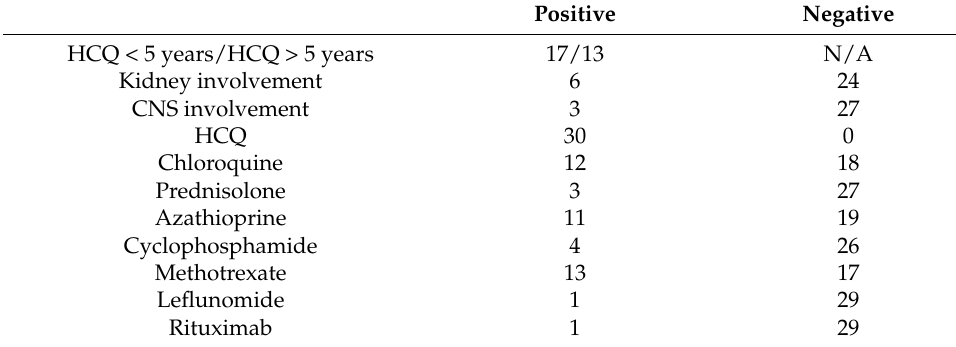
Table 2. Rheumatological